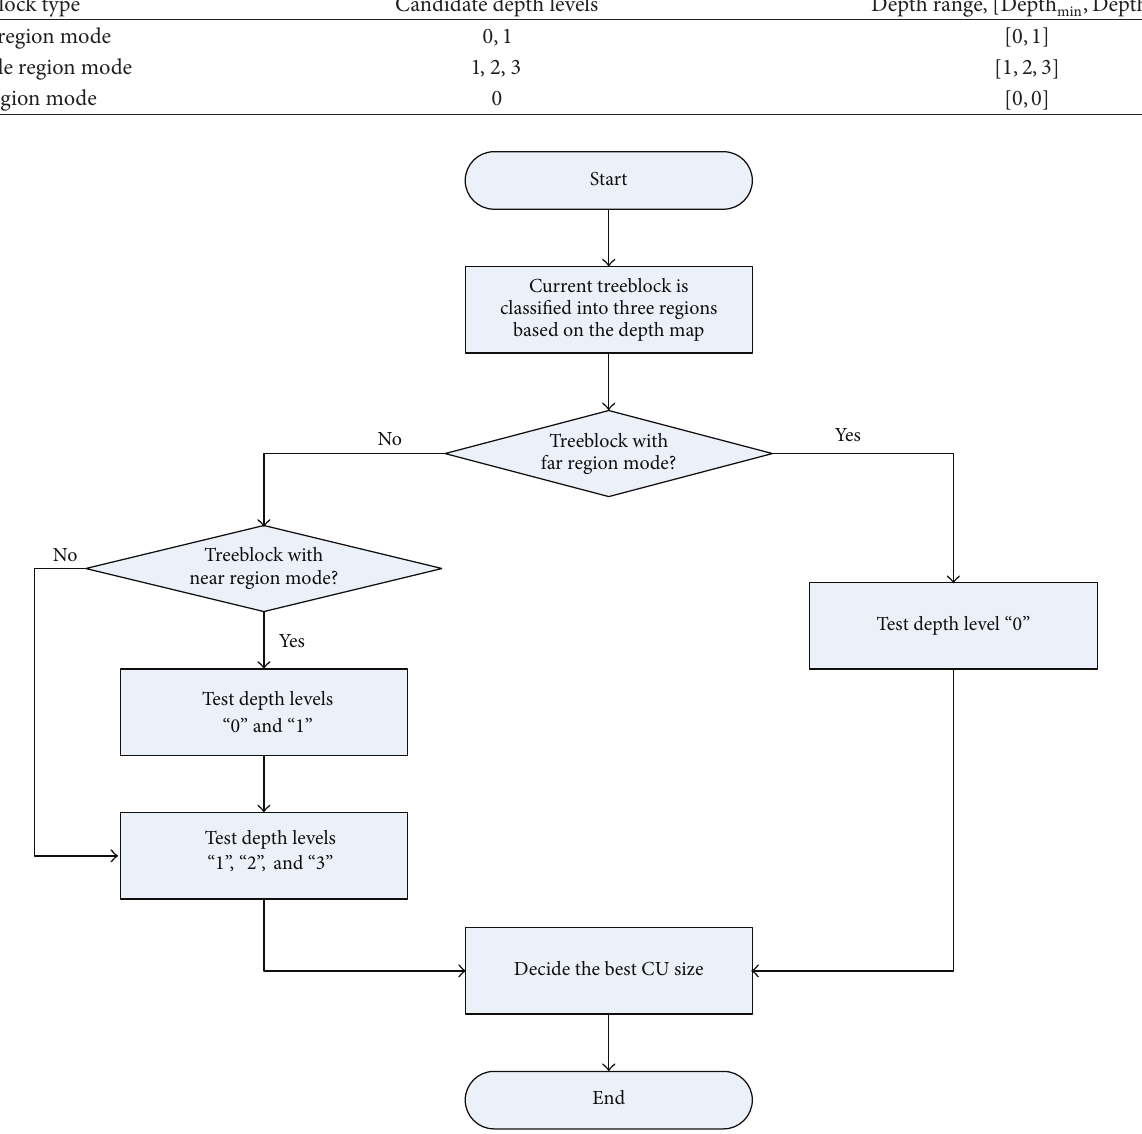
Figure 2: Flowchart of the proposed fast CU size decision